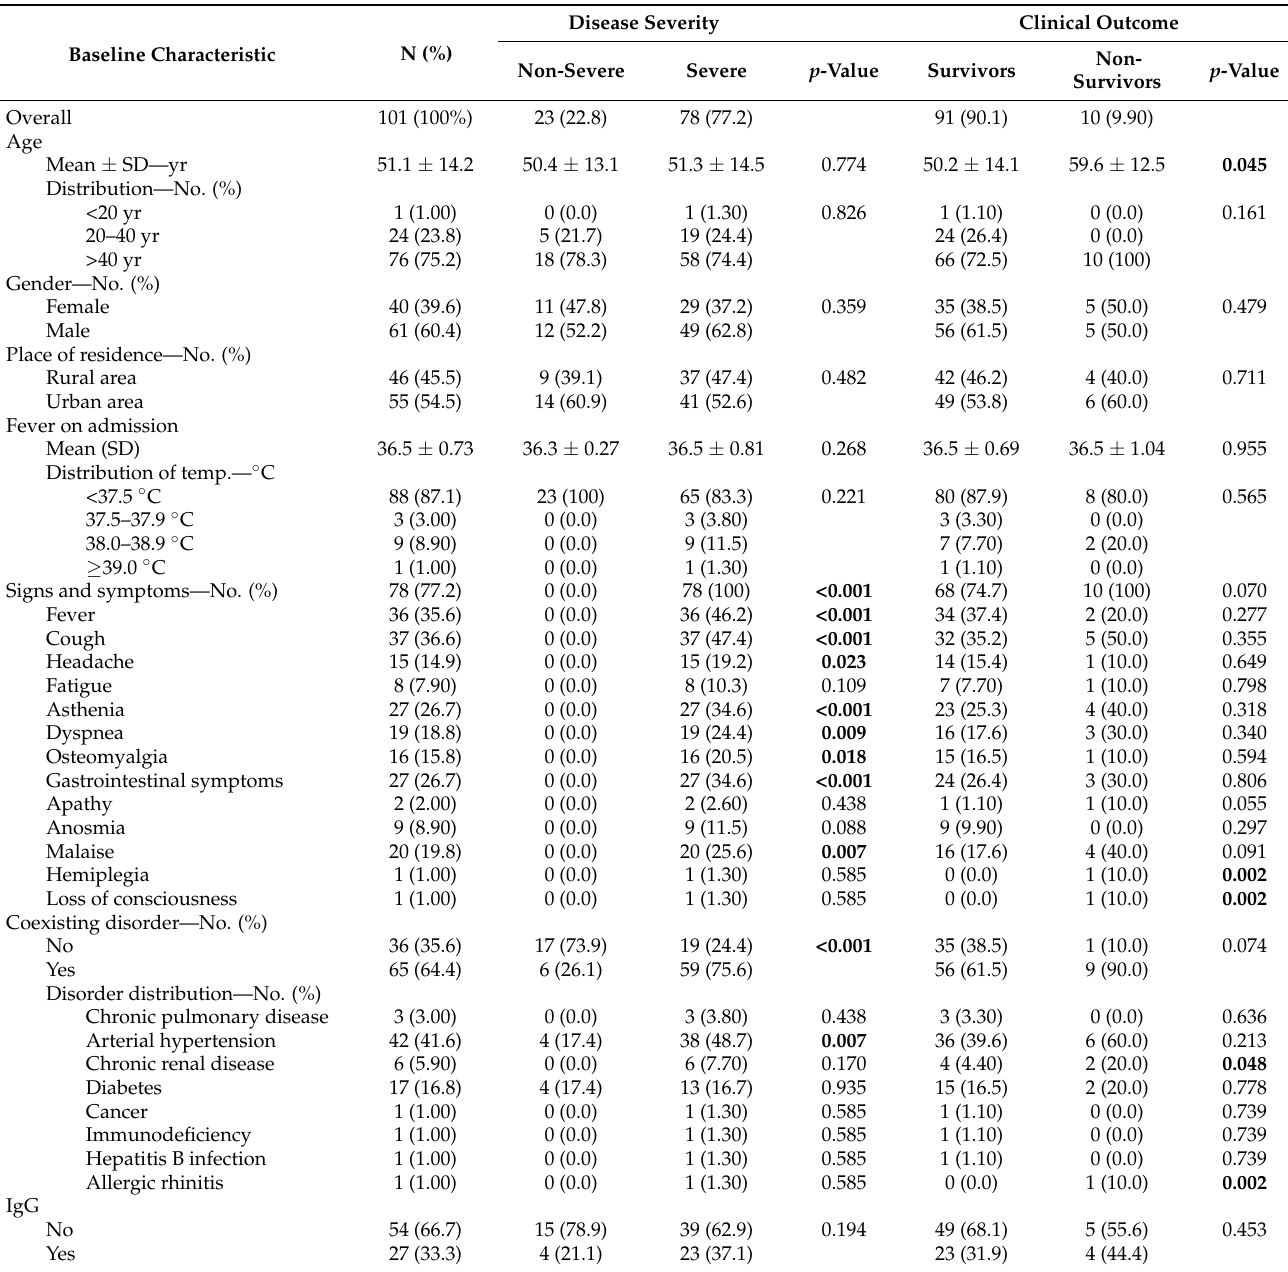
Table 1. Baseline characteristics related to disease severity and clinical outcome among COVID-19 patients in Luanda,